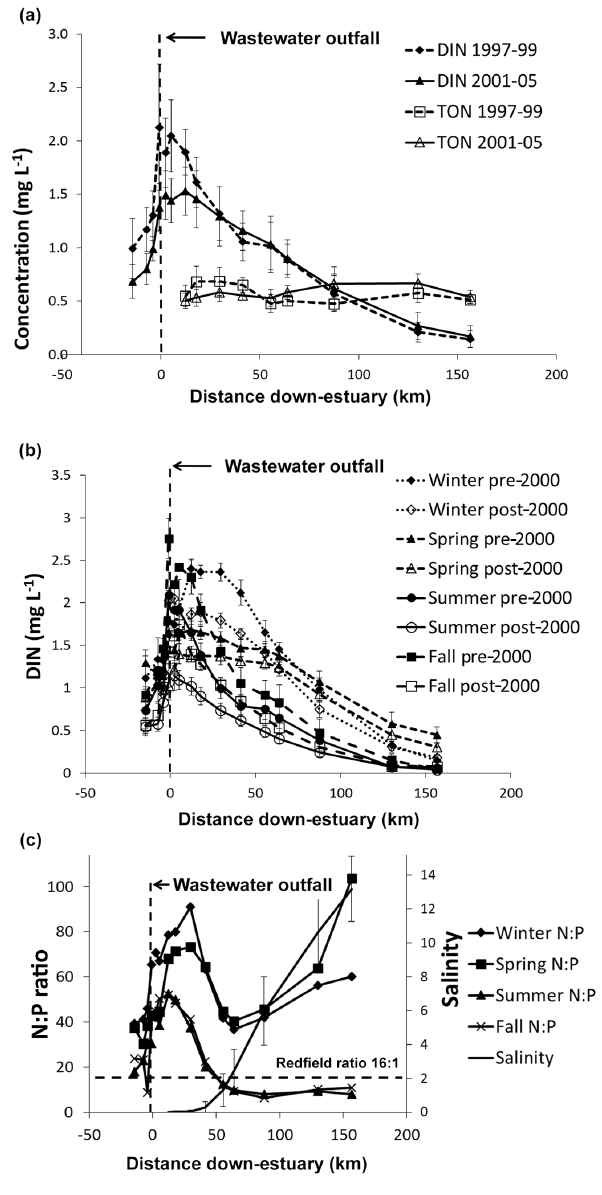
Figure 3. Longitudinal patterns in Potomac River estuary: (a) mean annual dissolved inorganic nitrogen (DIN) and total organic nitro- gen (TON) spanning 1997 to 2005, (b) mean seasonal DIN be- fore year 2000 (1994 to 1999), and post-2000 (2001 to 2012), and (c) mean (1994 to 2012) seasonal molar N:P ratio (DIN / PO − 3 with salinity averaged from all seasons (1984 to 2008). Note: er- ror bars are provided, but SE is relatively small compared to con- centrations. Data were obtained from the Maryland DNR and the Chesapeake Bay Program Data Hub.